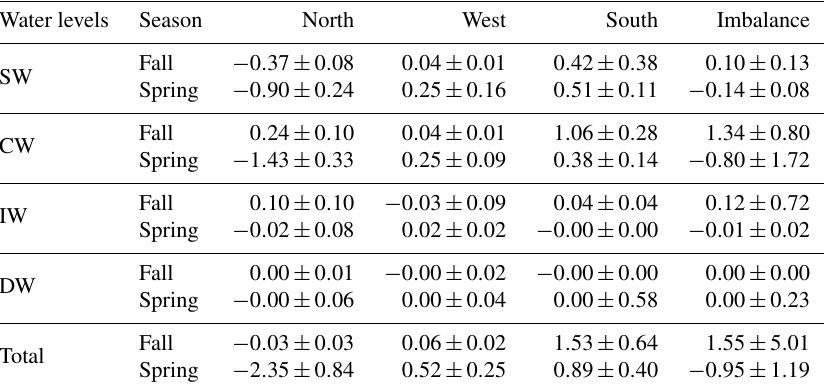
Table 8. DOC transports and their errors (10 8 molCd − 1 ) for CW, IW and DW for the north, west and south transects. Positive–negative values indicate outward–inward transports. The last row is the integrated transport in the entire water column in each transect, and the last column represents the net transport for this variable inside the box. These values are transports of non-refractory DOC, which is obtained by subtracting an amount of 40µmolL − 1 from the measured